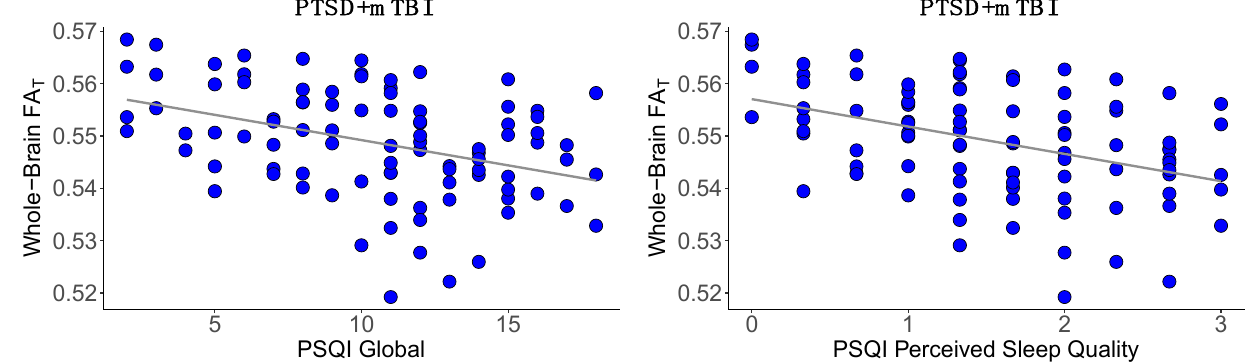
Figure 2. Association between sleep quality and whole-brain FA T . Note. PSQI, Pittsburgh Sleep Quality Index [76]; PTSD, post-traumatic stress disorder; mTBI, mild traumatic brain injury; FA T , fractional anisotropy tissue. This figure illustrates the significant negative association between global sleep quality and whole-brain FA T ( p < 0.001) and between perceived sleep quality and whole-brain FA T ( p < 0.001). Lower scores on the PSQI scales represent better sleep quality.